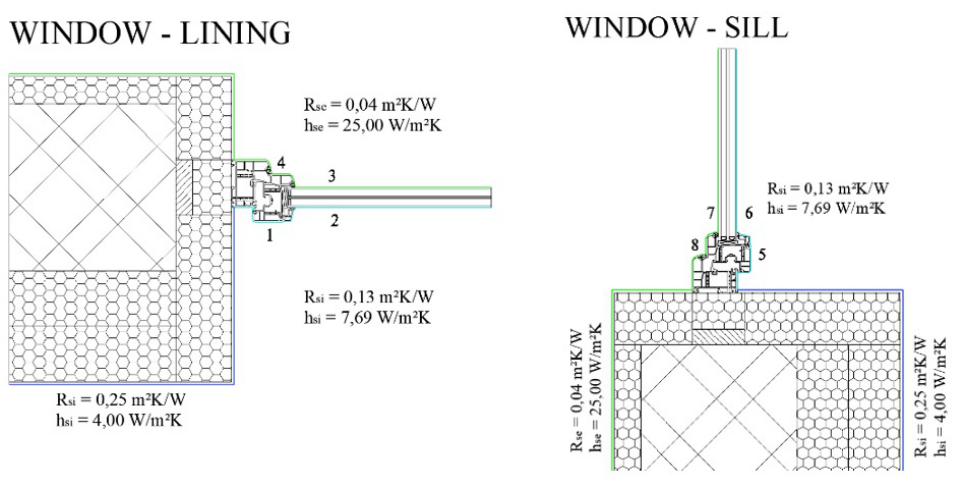
Figure 2. Detail of the window in the wall of the laboratory. Marked positions for comparison of surface temperatures.